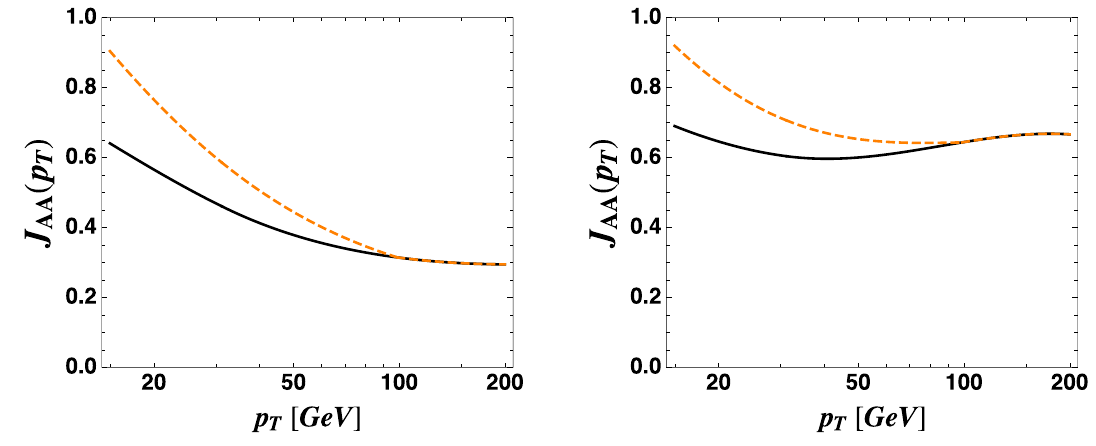
leading term of soft-gluon approximation of the BDMPS-Z spectrum; on the right side, we included numerical corrections to the quenching, as in Refs.